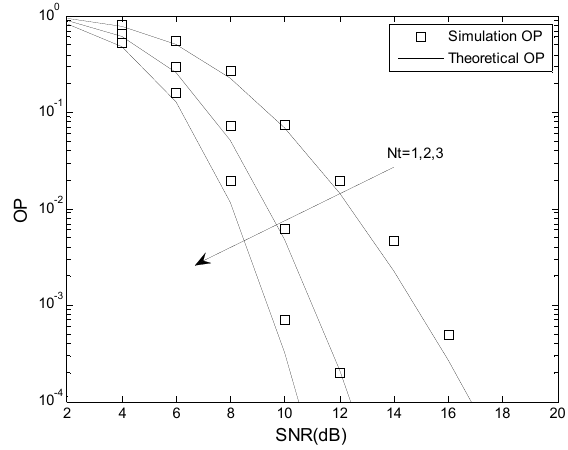
Figure 4. The OP performance of the optimal TAS scheme when γ th < γ P.